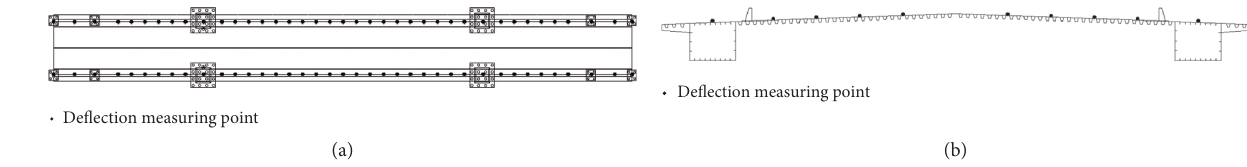
Figure 5: Layout of deflection measuring points. (a) The measuring points of deflection longitudinal distribution. (b) The measuring points of deflection transverse distribution.